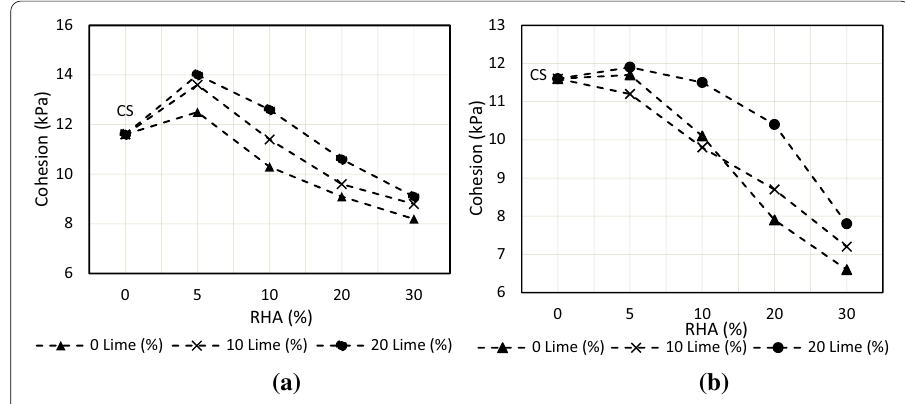
Fig. 6 Effect of RHA and lime mixture on cohesion a Soon after mixing b 28 days after mixing